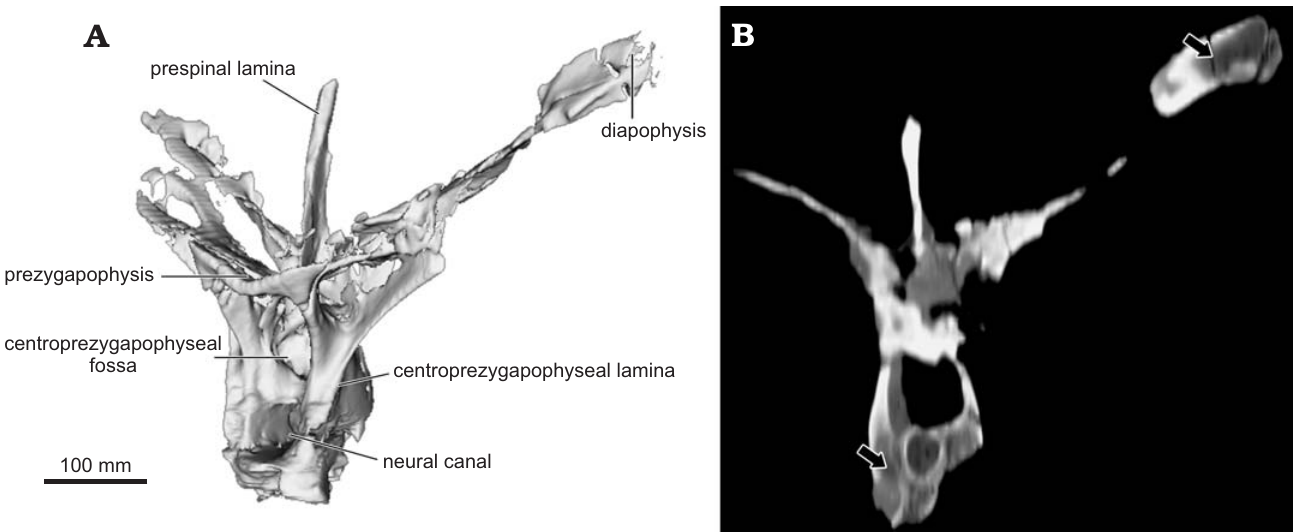
Fig. 3. Partial anterior to middle dorsal vertebra (UNPSJB-PV 1007/12) of the rebbachisaurid sauropod Katepensaurus goicoecheai Ibiricu, Casal, Martínez, Lamanna, Luna, and Salgado, 2013a from the Cenomanian–Turonian Bajo Barreal Formation of Chubut Province, Argentina . A . Computed tomography (CT)-based digital reconstruction in left anterolateral view. B . Axial CT “slice” in anterior view, with hypothesized pneumatic structures indicated by arrows. Note internal cavity in left